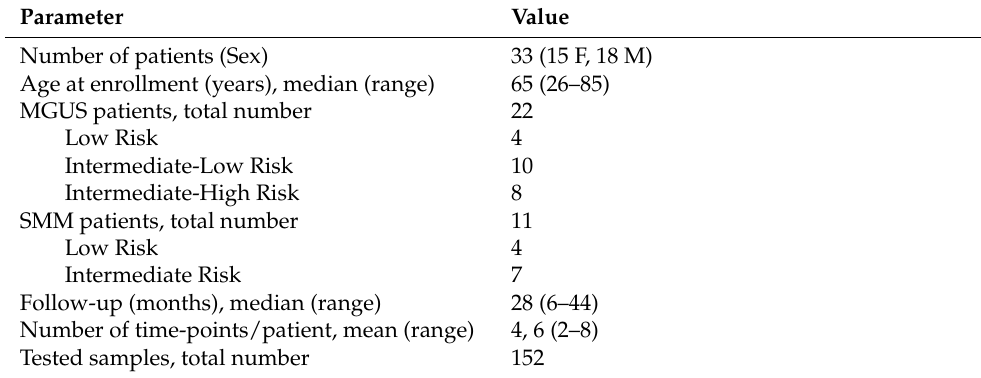
Table 1. Clinical characteristics of MGUS/SMM patients enrolled in this study. Risk categories are defined according to Mayo Clinic